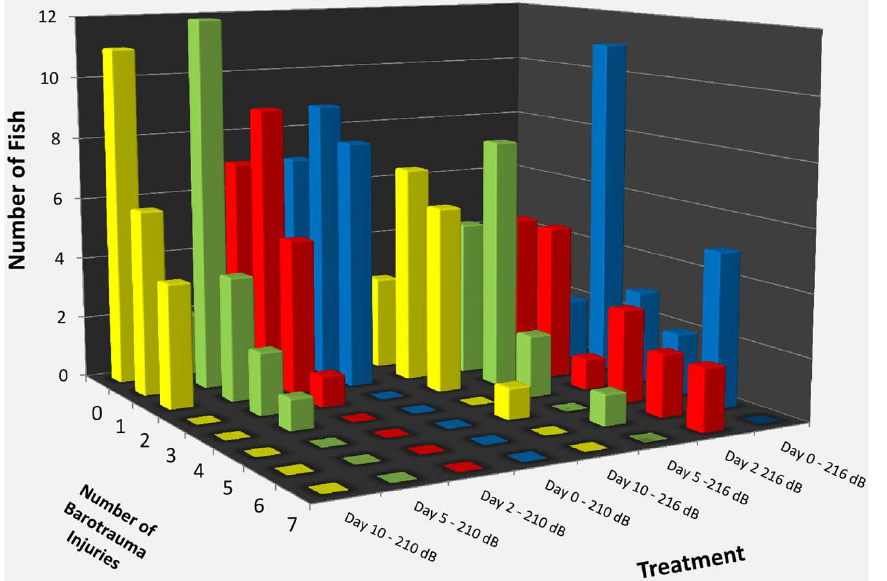
Figure 3. Number of observed injuries. Injuries that were observed in Chinook salmon for Exposure 1 and 2 as well as the different days post- exposure. There were a higher number of injuries observed at Exposure 1 versus Exposure 2. Numbers of injuries observed were higher at the earlier days post-exposure for Exposure 1 compared with the later days indicating that healing was occurring.